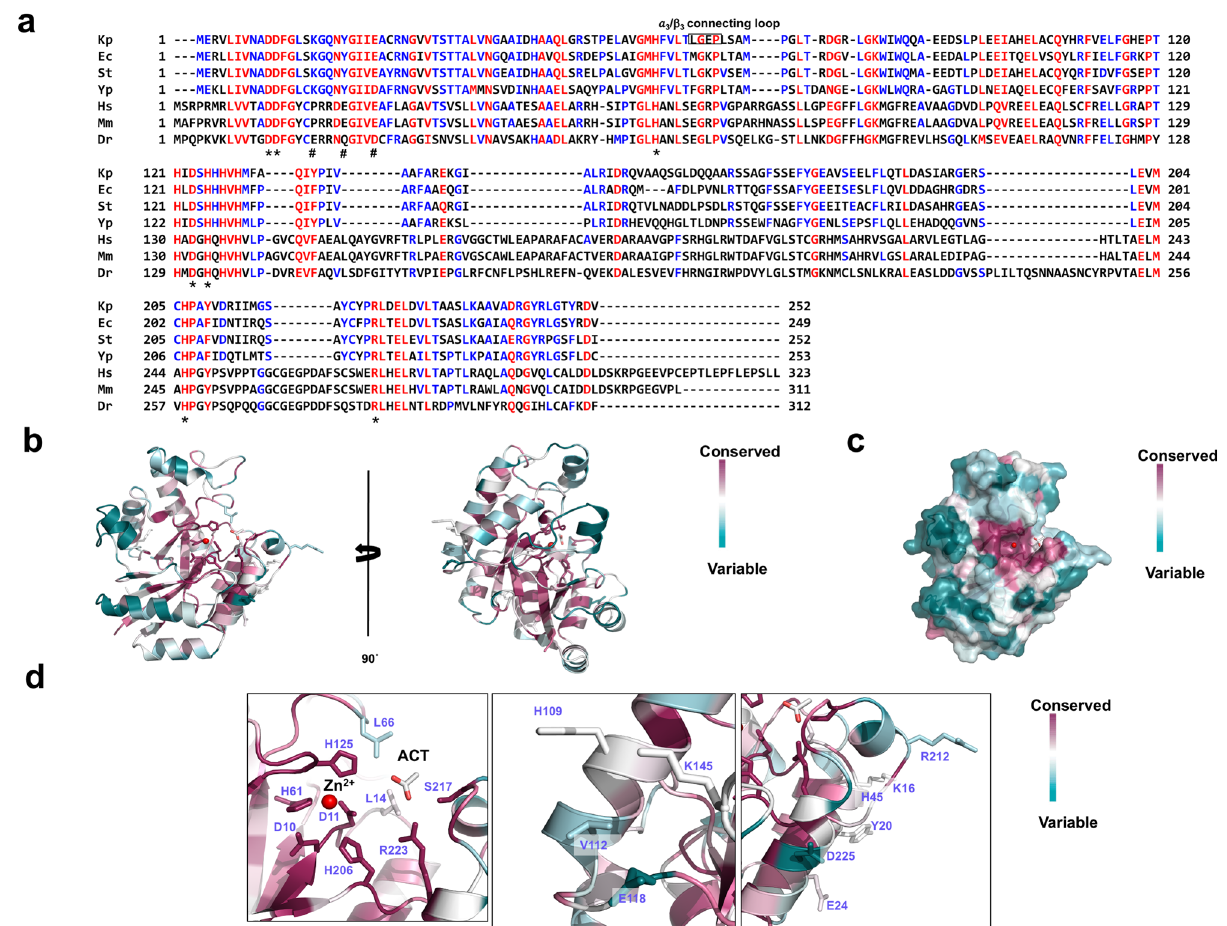
Fig. 6 Sequence comparison of prokaryote and eukaryote ChbG homologs. a Sequence alignment using Clustal Omega Completely conserved and partially conserved residues are shown in red and blue, respectively. The position of the α 3/ β 3 connecting loop is indicated by a black square. Conserved residues that are involved in the formation of the putative active site and the A/B ’ dimer are indicated by asterisks (*) and hashes (#), respectively. Kp: Klebsiella pneumoniae , Ec: Escherichia coli , St: Salmonella typhimurium , Yp: Yersinia pestis , Hs: Homo sapiens , Mm: Mus musculus , Dr: Danio rerio . b Cartoon representation of kpChbG colored according to the degree of amino acid sequence conservation generated by the ConSurf server 29 . c Surface representation of kpChbG. d Three close-up views of panel ( b ) showing the amino acids of the putative active site, the fi rst dimer PPI, and the second dimer